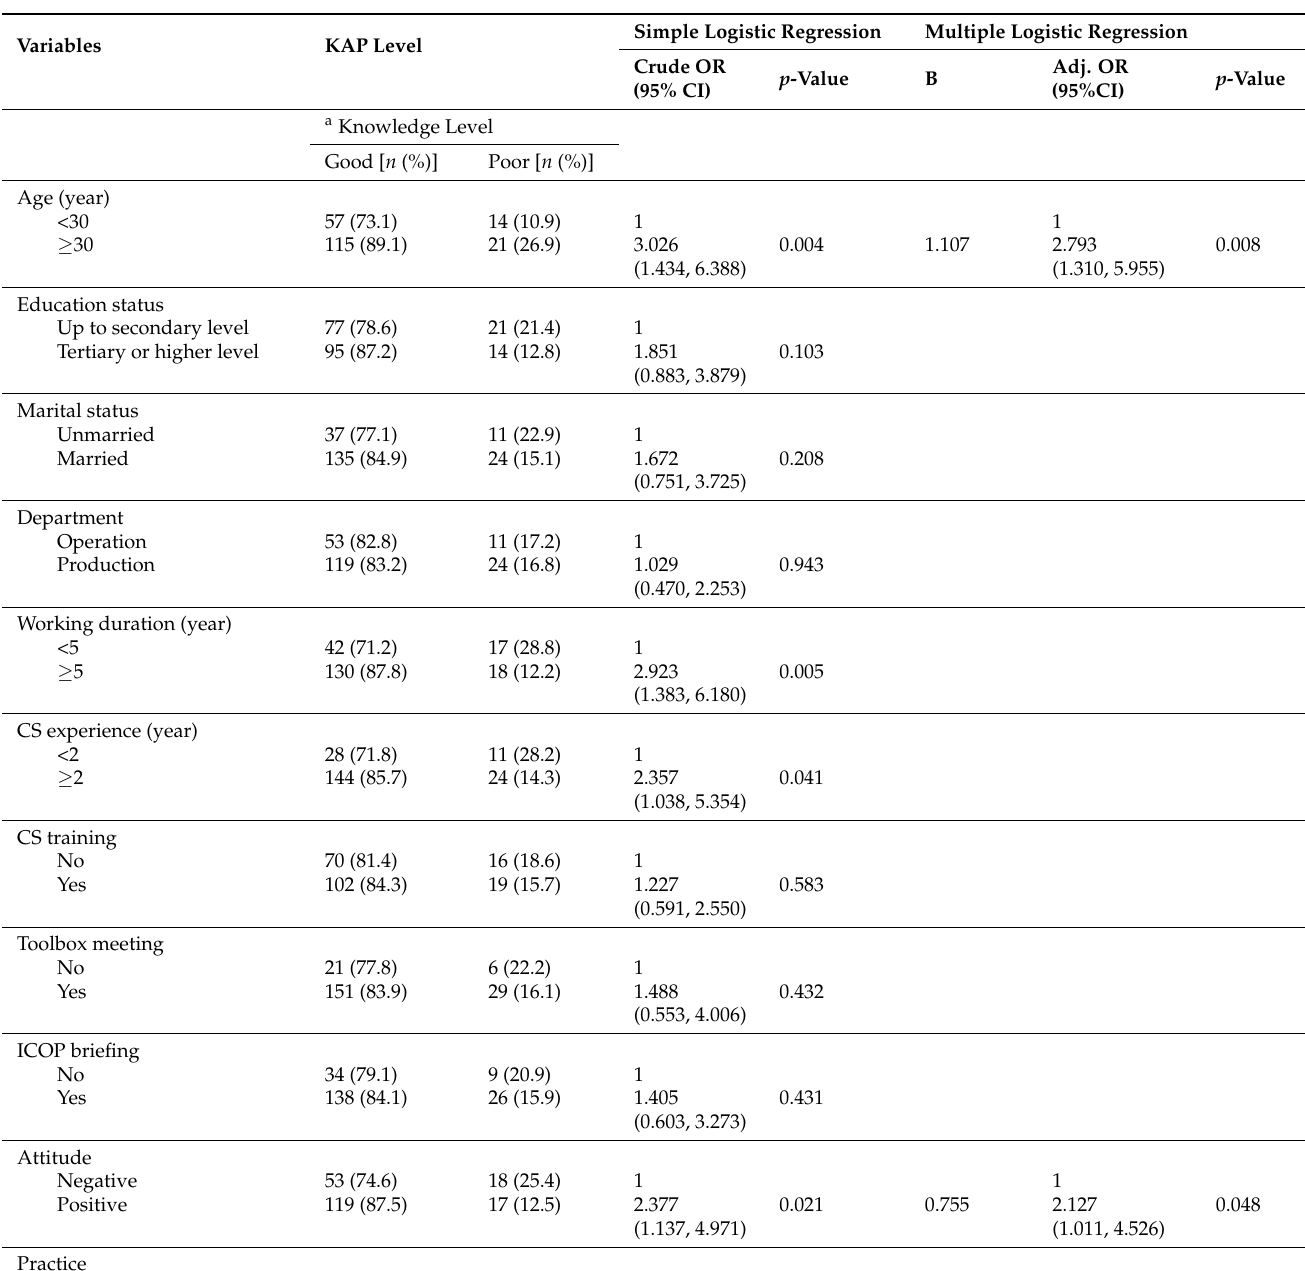
Table 4. Factors associated with KAP towards safe working in a confined space by simple and multiple logistic regression analyses ( n =